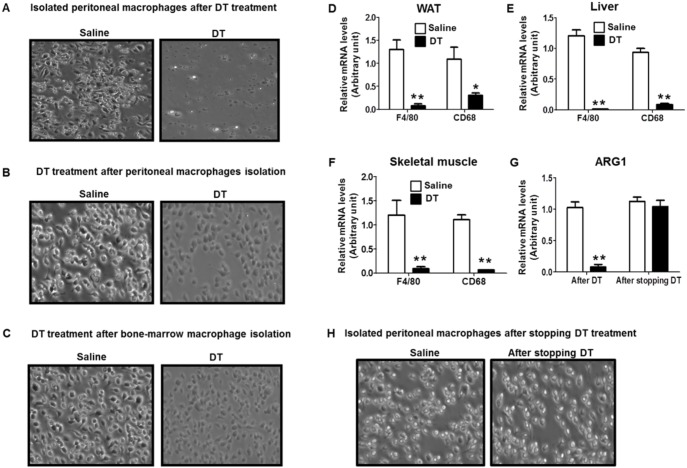
DT treatment efficiently depletes macrophages.For microscopic images of macrophages, macrophages were collected from peritoneal lavage of LysMCre/iDTR mice (A) 2 days after DT treatment (10 ng/g body weight) and (H) 7 days after stopping DT injection. Macrophages were collected from (B) peritoneal lavage or (C) bone-marrow of LysMCre/iDTR mice, then treated with saline or DT (0.25 ng/ml) for 8 hours. mRNA levels of macrophage marker F4/80 and CD68 were measured in (D) WAT, (E) liver, and (F) skeletal muscle of mice treated with saline or DT for 2 days. mRNA levels of M2 macrophage marker ARG1 were measured in (G) WAT of mice treated with saline or DT for 2 days and 7 days after stopping DT injection. Data are represented as mean ± SEM. Asterisks denote significant differences *P<0.05, **P<0.01 vs. saline-treated mice.